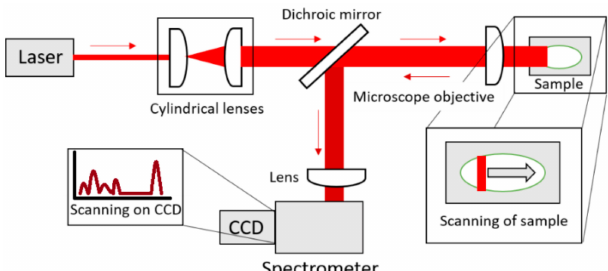
Figure 8. Illustration of LSRM (top view). A laser line is formed by two cylindrical lenses and focused via a microscope objective onto the sample. A translational stage moves the sample. The microscope objective collects the Raman signal from the sample in the backward direction. The Raman signal is separated from the laser light with the dichroic mirror. Focusing into the spectrometer is achieved with an additional